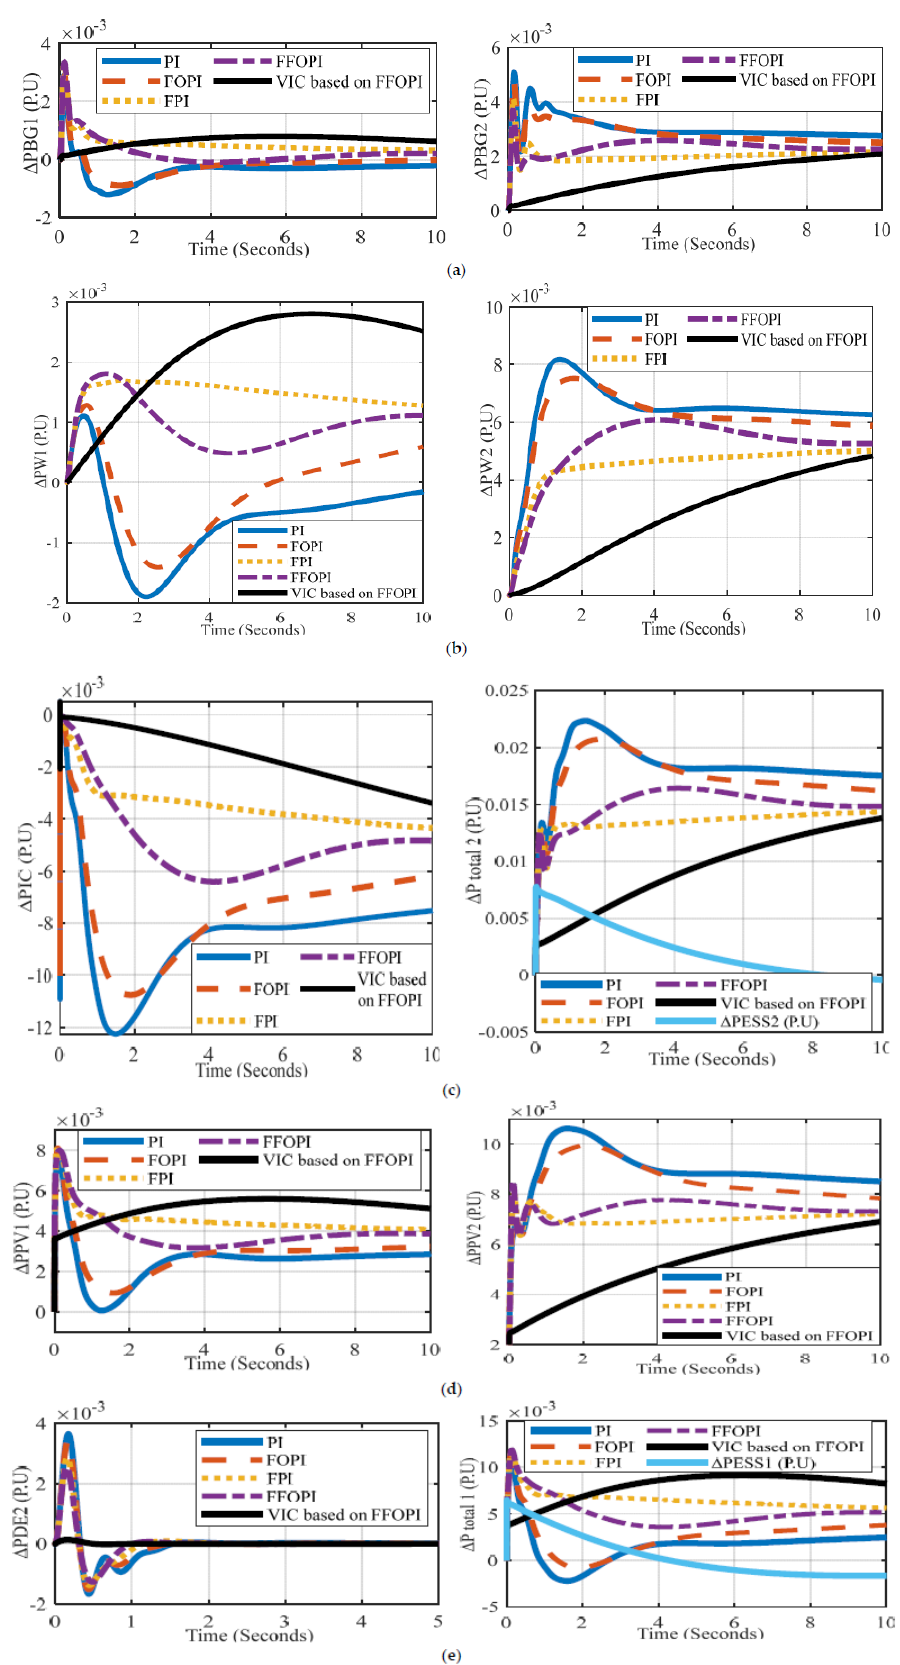
Figure 16. M 1 and M 2 ’s active power measurements versus time for each controller at solar